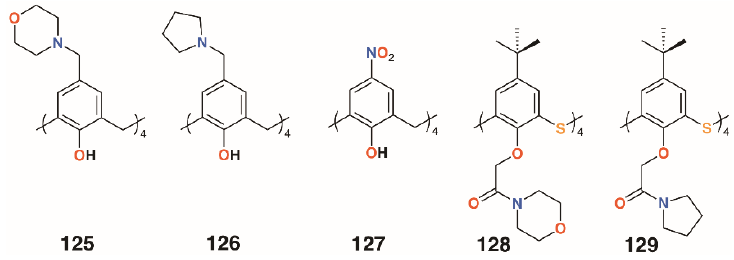
Figure 19. Morpholine and pyrrolidine calixarene derivatives from Memon and Galitskaya.